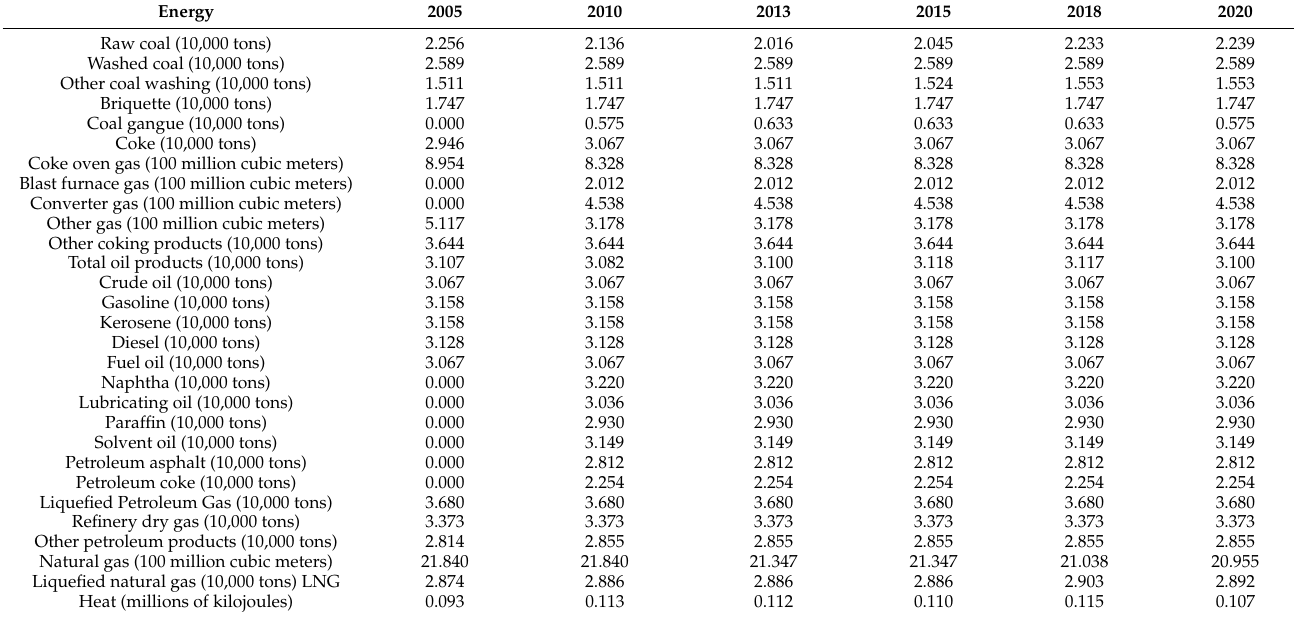
Table A1. Energy conversion coefficient of the studied